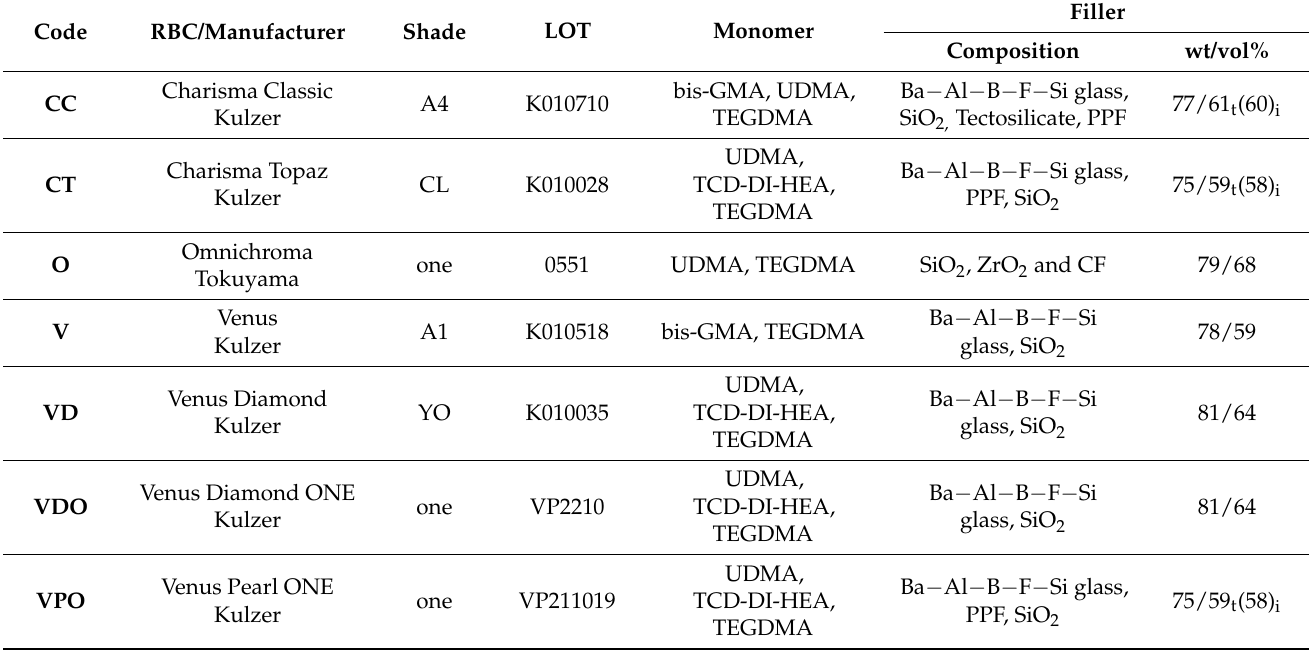
Table 1. Analyzed RBCs and chemical composition as indicated by the